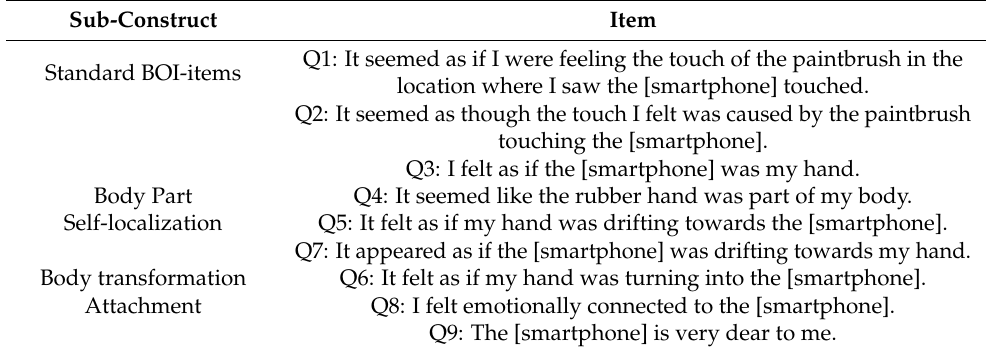
Table 1. Explicit measurement of BOI, sub-constructs and sample questionnaire of the conditions with